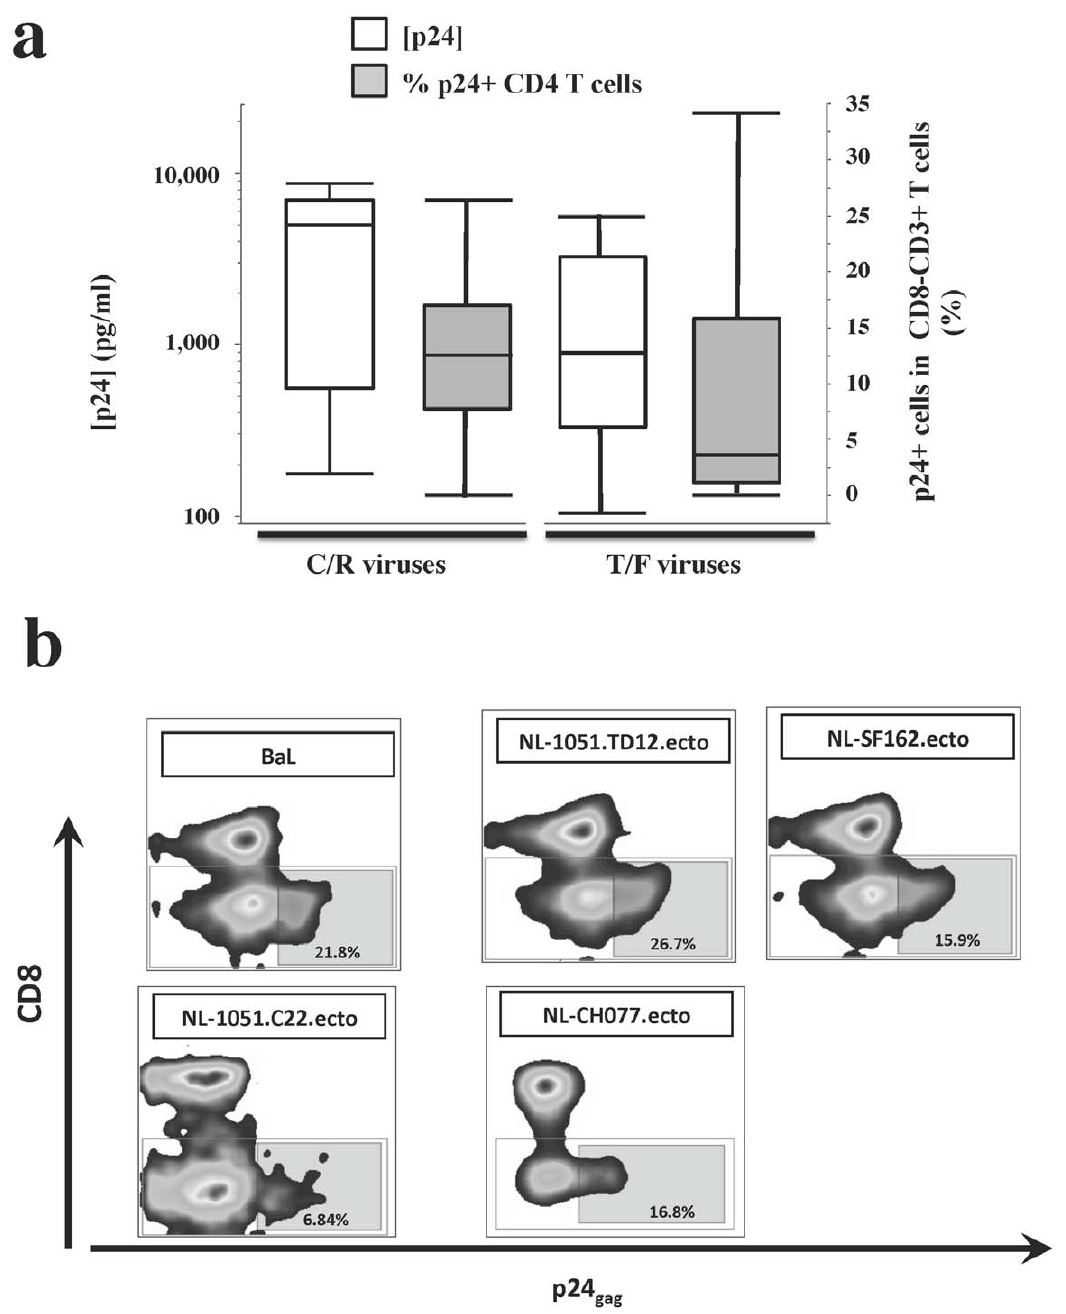
Figure 1. Replication of various C/R and T/F HIV-1 variants in human cervical tissue exvivo . Donor-matched human cervical tissue blocks were infected ex-vivo with C/R and T/F viruses in presence or absence of 3TC. Culture media were collected every 3 days up to day 12 and the amount of p24 was measured. In addition, 12 days post infection, the tissues were enzymatically digested and their cells were analyzed by polychromatic flow cytometry. T cells were identified by side-scatter and staining for CD3. The CD4 T cell subset was defined as CD8 – T cells since the down-regulation of CD4 in HIV-1 infected cells precludes use of staining for CD4. CD4 T cell, which were infected with HIV-1 were revealed by staining for p24.(a) For each virus, cumulative values for the net p24 production ([p24] in untreated 2 [p24] in 3TC-treated donor-matched tissues) were computed and plotted as box plots (median, 25 th and 75 th percentiles, and range) on a log scale (left Y-axis; empty boxes; C/R virus: n=23; T/F viruses: n=30). The fractions of p24 + positive cells among CD8 2 CD3 + cells were plotted on a linear axis (right Y-axis; filled boxes; n=19, and n=14, respectively) (b). Bivariate plots showing p24 and CD8 staining in T cells; the values represent the fraction of CD8 2 CD3 + cells expressing p24 as defined by the plotted gate. Plots illustrate a representative experiment. doi:10.1371/journal.pone.0050839.g001 T cells was not different in tissues infected by T/F or C/R HIV-1 Thus, in tissues infected either with C/R or T/F HIV-1 variants (p . 0.77 ). variants, the fraction of activated CD4 T cells, either infected or